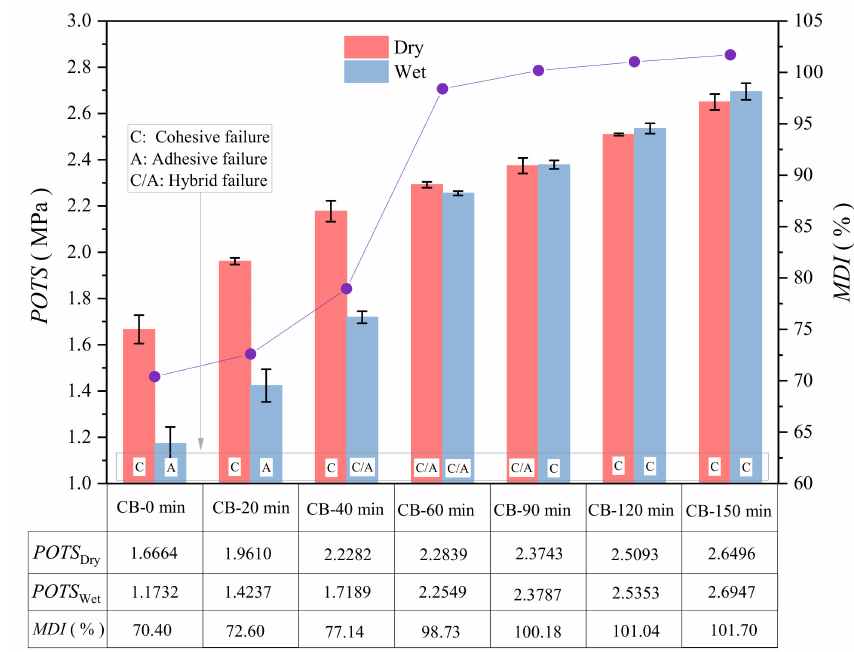
Figure 19. Results for CB-aggregate system under various treatment